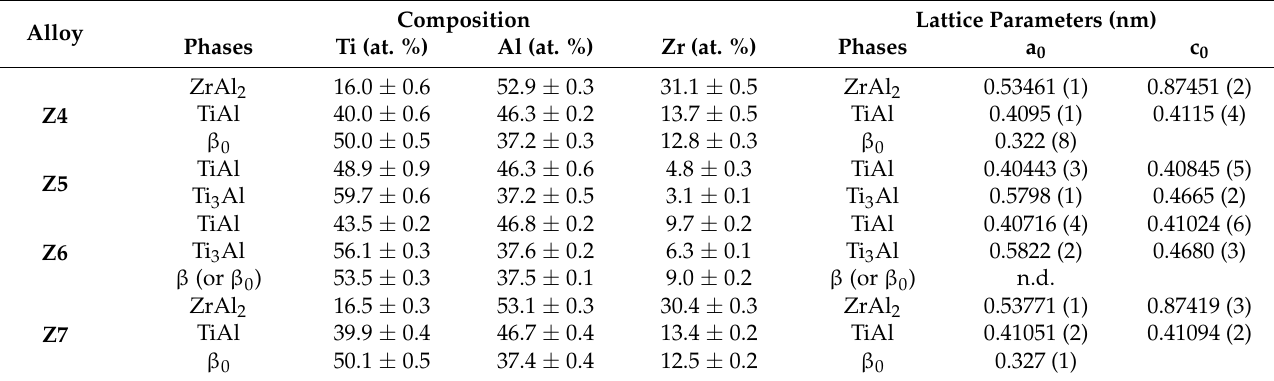
Figure 6. BSE micrograph of alloy Z4 (Ti-40.8Al-15.2Zr at. %) heat treated at 1100 °C/200 h showing the phase equilibrium β 0 + ZrAl 2 + TiAl and sporadic small grains of Zr 5 Al 3 . At 1100 °C, alloys Z4 and Z7 comprise β 0 + TiAl + ZrAl 2 , and alloy Z6 represents the three-phase equilibrium β 0 + Ti 3 Al + TiAl. From the overall composition of Z6, it is evident that the sample contains only a minor volume fraction of β 0 . Therefore, it was not possible to establish the ordering by XRD, but from the results at 1000 °C (Figure 1) and 1200 °C